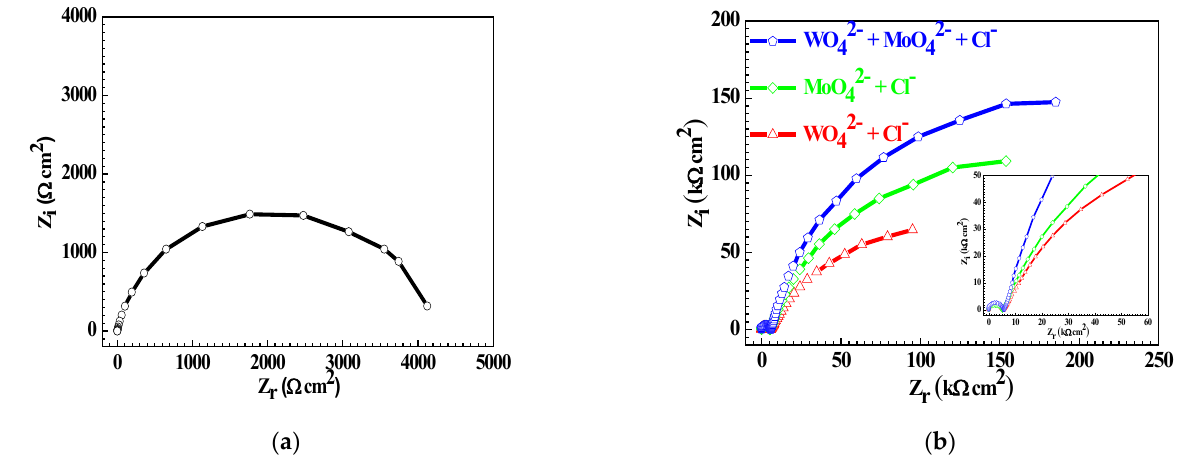
Figure 10. EIS of the Q235 samples in 0.1 mM NaCl solution ( a ) and in WO 4 2− + Cl − , MoO 4 2− + Cl − and WO 4 2− + MoO 4 2− + Cl − solutions ( b ).